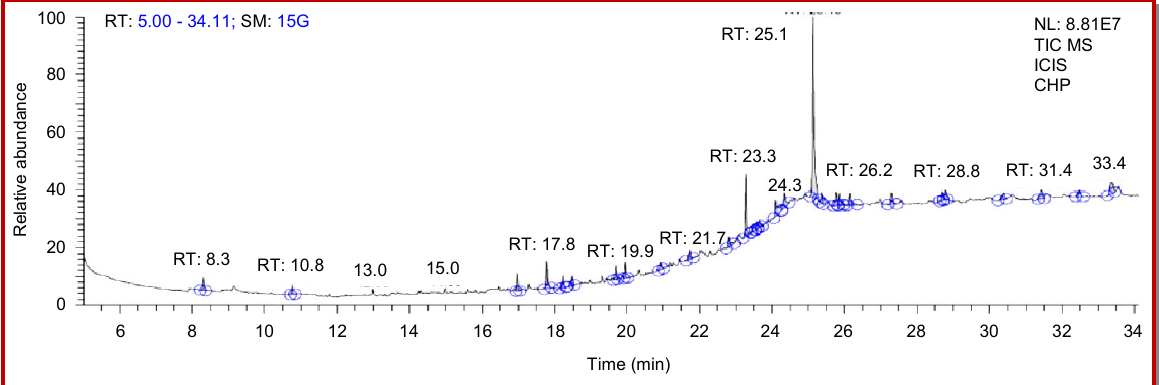
Figure 3: GC-MS chromatogram chloroform extract of Hamelia